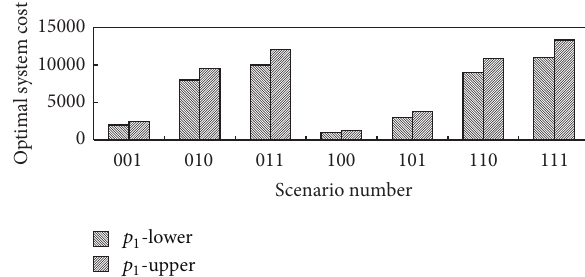
Figure 3: Optimal costs under low contaminant ingression/genera- tion level.